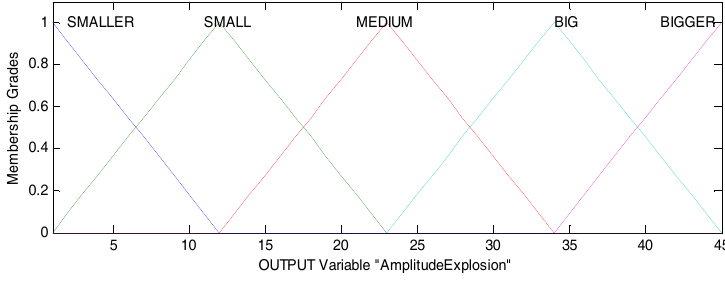
Figure 8. Output variable of DPFFWA-I (AmplitudeExplosion).